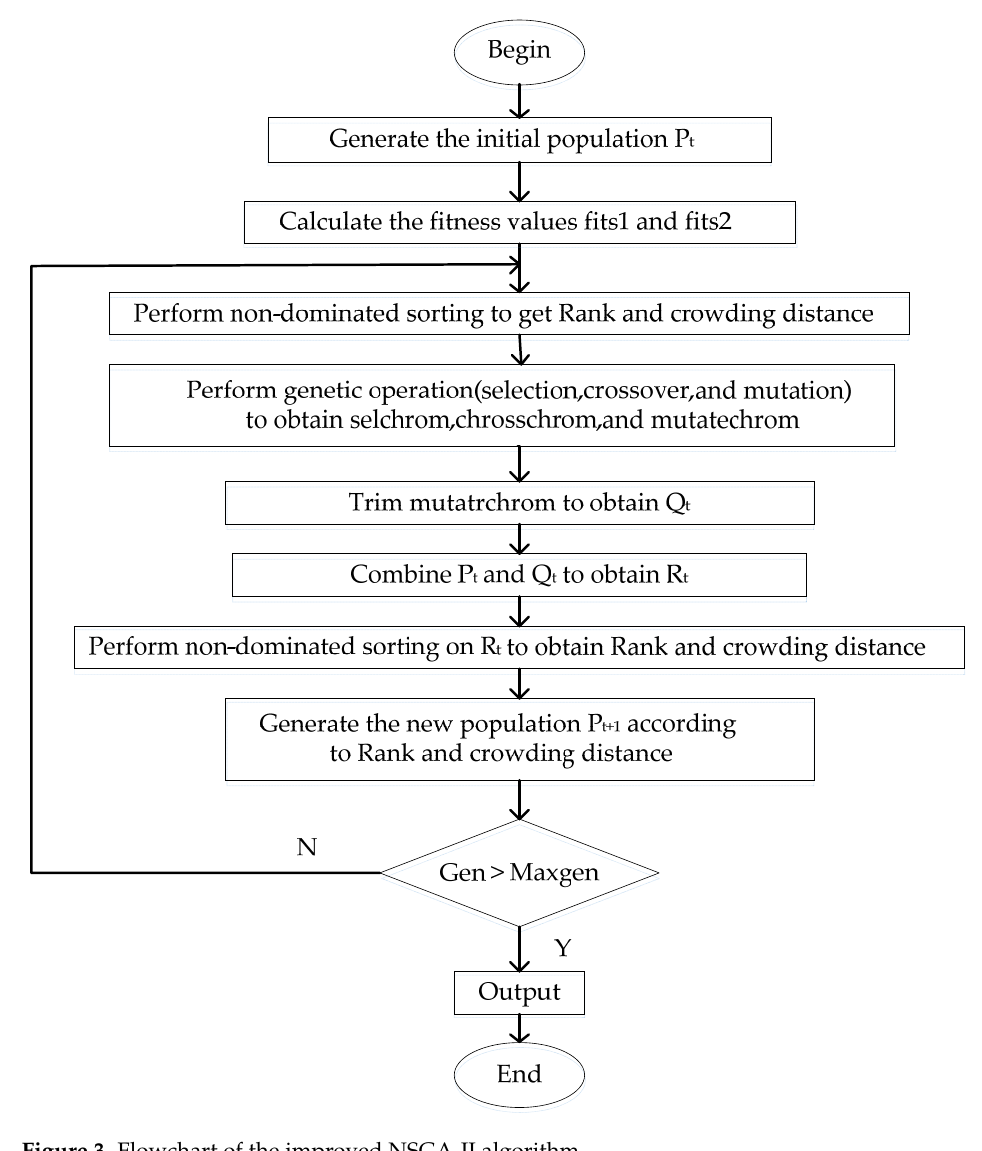
Figure 3. flowchart of the improved NSGA-II algorithm. Figure 3. Flowchart of the improved NSGA-II algorithm.